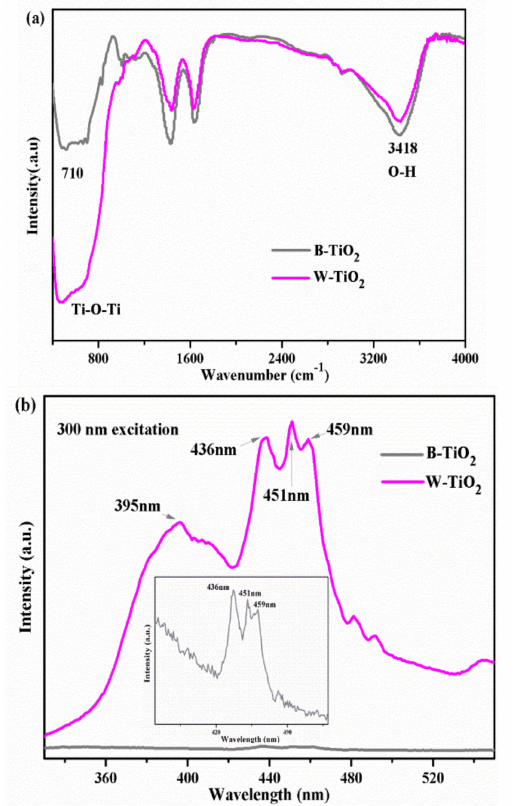
Figure 6. ( a ) FT-IR spectra of B-TiO 2 and W-TiO 2 nanoparticles; ( b ) Photoluminescence spectra of B-TiO 2 and W-TiO 2